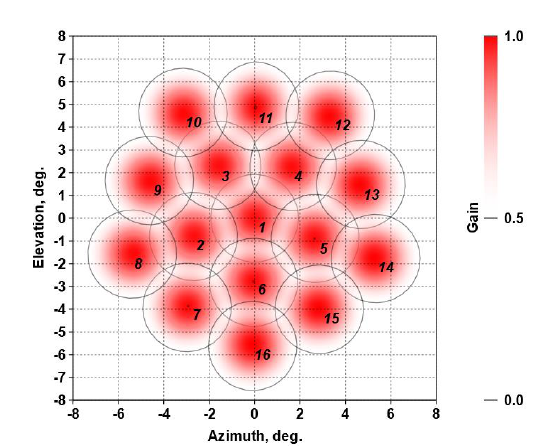
Fig. 1. Radiation pattern of a simulated